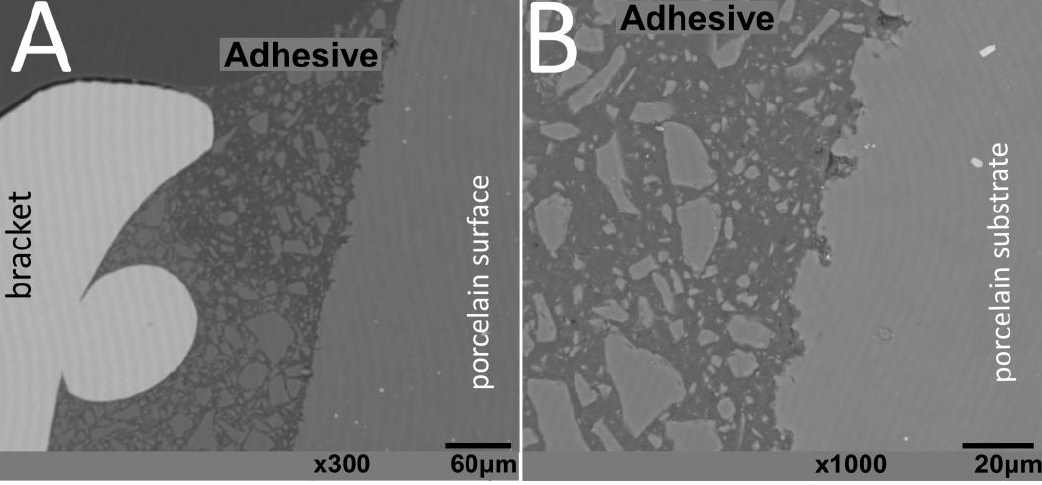
Figure 4. SEM images of metallic brackets bonded to ( A , B ) glass – ceramic or ( C , D ) acrylic surfaces. Structural defects and cracks were noted at the bracket – adhesive – substrate interfaces after thermal cycling (Figures 2 – 5). Cracks were more noticeable between the ceramic bracket and the adhesive in the teeth group (Figure 3) and between the adhesive and acrylic surfaces (Figure 5). Leucite-based glass – ceramic specimens showed the fewest changes after thermal cycling (Figure 5).